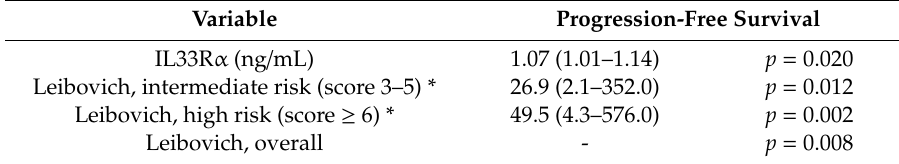
Table 3. The impact of IL33R α for progression in 67 patients randomly selected out of 83 patients with clear-cell renal cell carcinoma assumed to be radically treated; a multivariate analysis including IL33R α together with the Leibovich score. The results are presented as the hazard ratio (95% confidence interval) and p